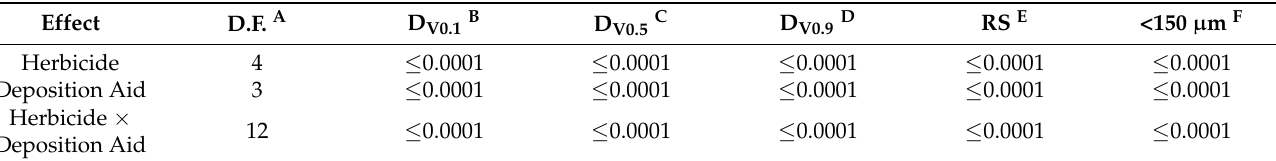
Table 5. Analysis of variance and associated p -values for droplet size parameters of herbicide solutions and deposition aids applied to